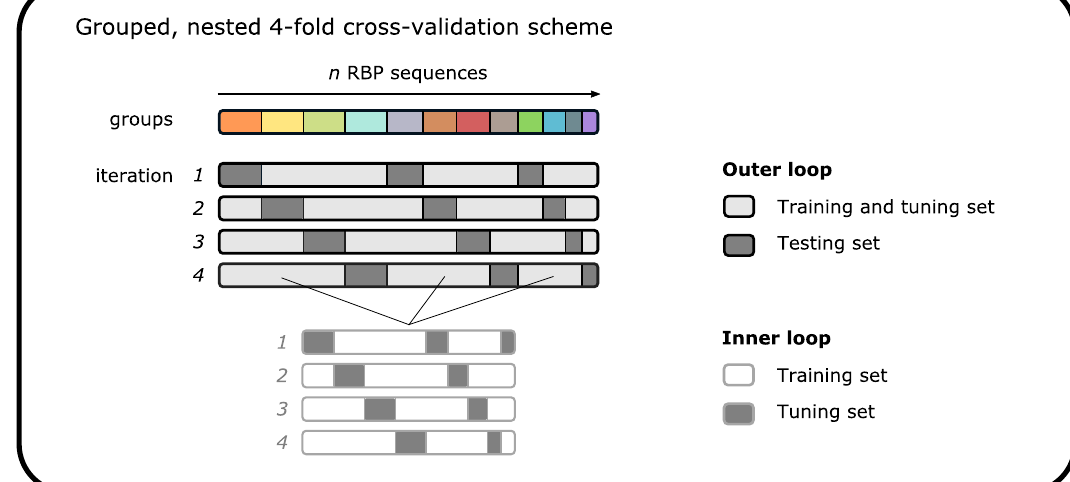
Figure 3. Grouped, nested fourfold cross-validation scheme to train and compare selected machine learning models. RBP sequences were grouped based on computed identity percentages between every sequence pair. In the inner loop, every model’s hyperparameters were optimized using grid search (with groups as defined before). In the outer loop, the performance of every optimized model was measured. In the outer loop as well, the defined groups control which sequences are in which